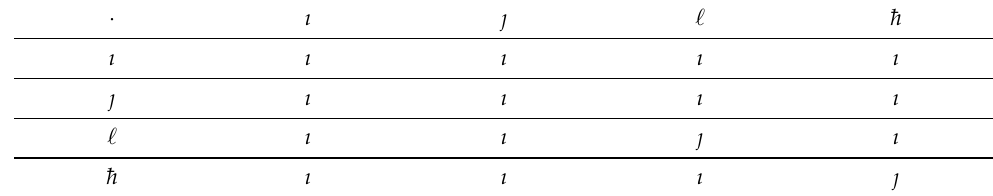
Table 3. Table of multiplication of P